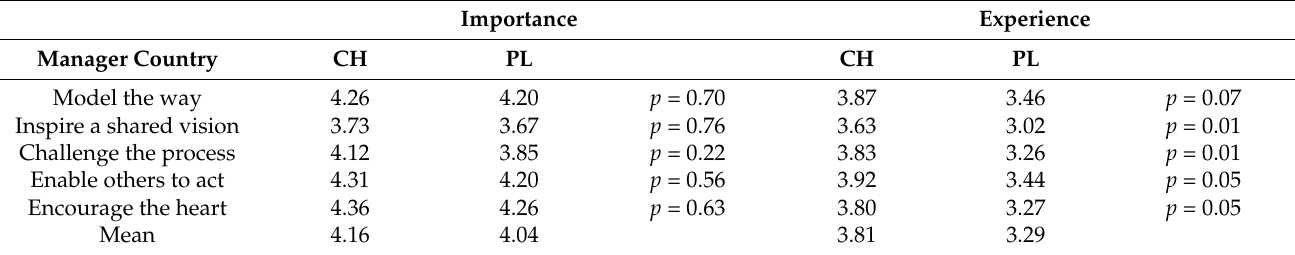
Table 6. Scoring of leadership practices for Polish employees by manager’s country.